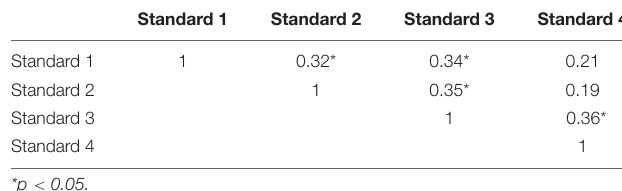
TABLE 3 | Correlations between IL scores.